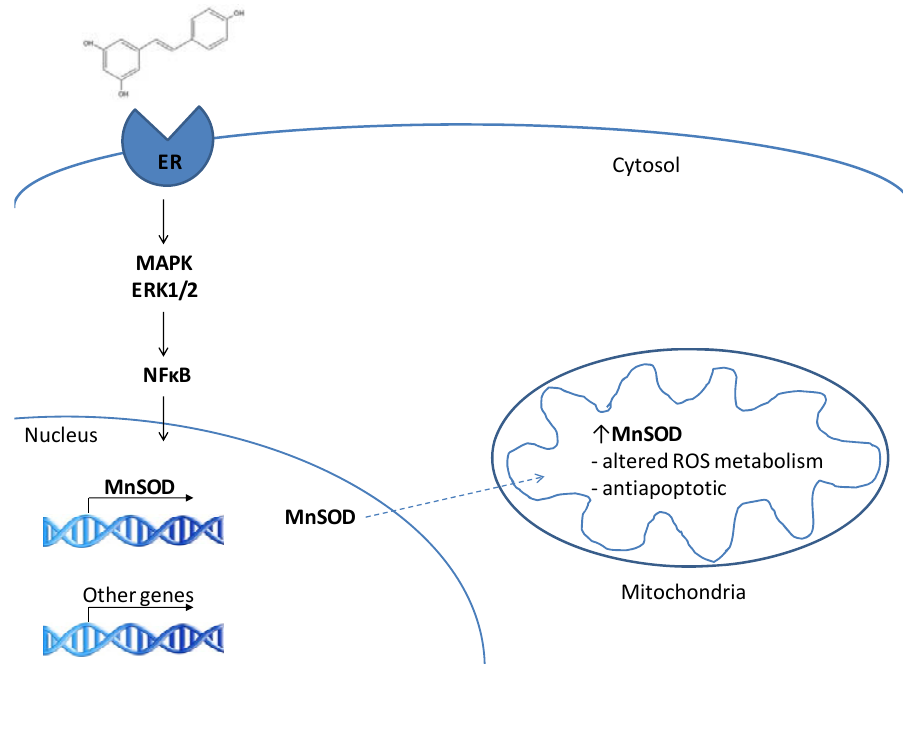
Figure 1. A proposed pathway for the RES-induced stimulation of MnSOD transcription via estrogen receptor-mediated regulation of NF κ B activity. Based on the E2-induced transcriptional upregulation of MnSOD and other mitochondrial proteins described by Borras et al . [63]. MAPK = mitogen activated protein kinase; ERK1/2 = extracellular signal regulated kinases ½; NF κ B = nuclear factor κ B; MnSOD = manganese superoxide